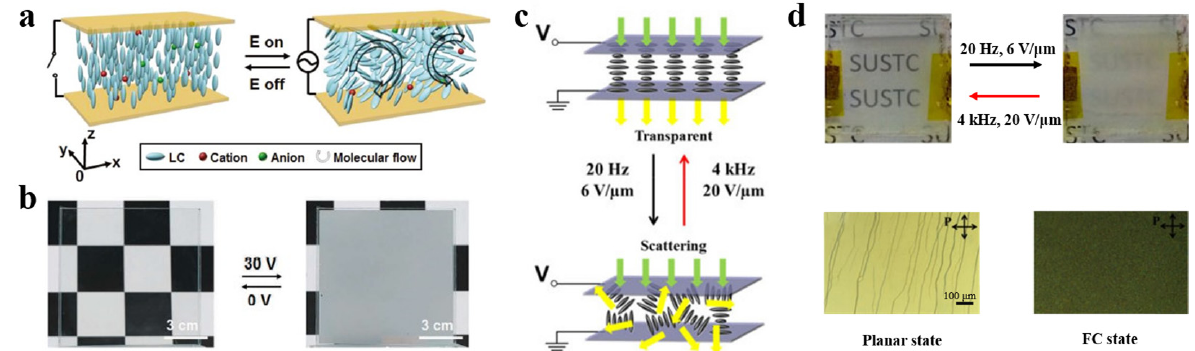
Figure 1. ( a ) Schematic diagrams and ( b ) image of the EHDI smart window based on the NLCs in the ON/OFF states [53]. ( c ) The operating principle of the bistable CLCs smart window. [58]. ( d ) The pictures and polarizing optical microscope (POM) images of EHDI smart window in scattering state and transparent state [58].